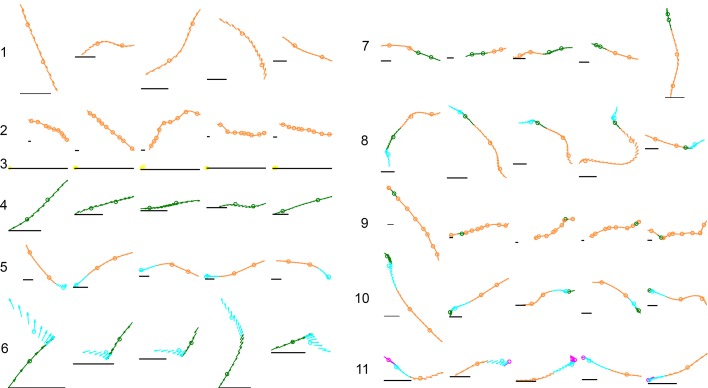
Examples of common mode sequences.Arrows represent a fly’s body orientation, shown at 33 time steps. Examples are colored by membership in a mode class of Markov model MM5, with each mode center marked by a circle on the trajectory. Gray horizontal scale bars = 3 mm, a representative length of an adult D. melanogaster female. Numbers reference locations in Figure 5C, ascending from the most common to the rarest sequence shown.